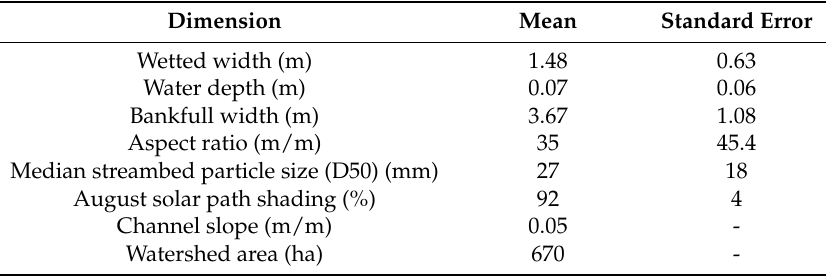
Table 1. Physical measurements of the Little Creek study site from 21 to 25 August 2014 taken at 25 m intervals along 825 m study